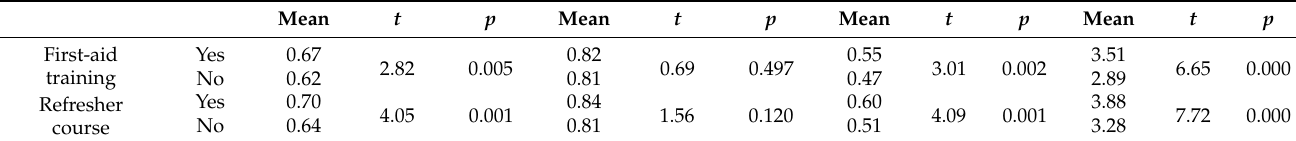
Table 3. Independent-samples t -tests on objective and subjective first-aid